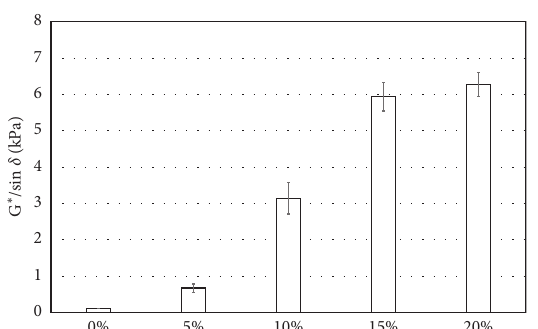
Figure 8: G ∗ /sin δ of SIS binders at 82 °